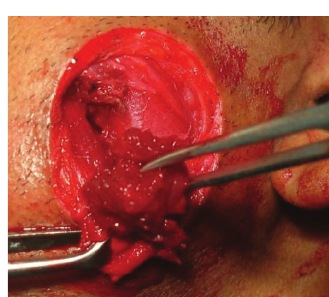
Figure 8: Hypertrophic muscle removed.